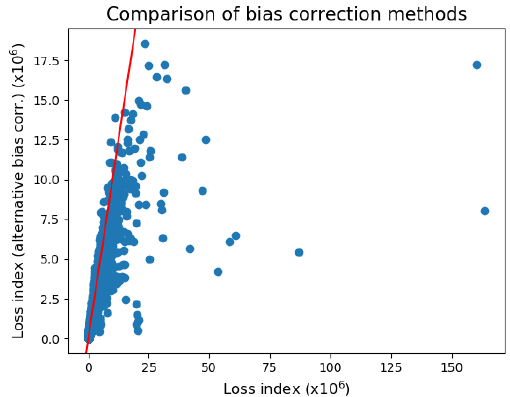
Figure 10. Scatter plot of European LI for individual footprints from the alternative bias correction method (Sect. 5) against LI us- ing the original method. The red line shows